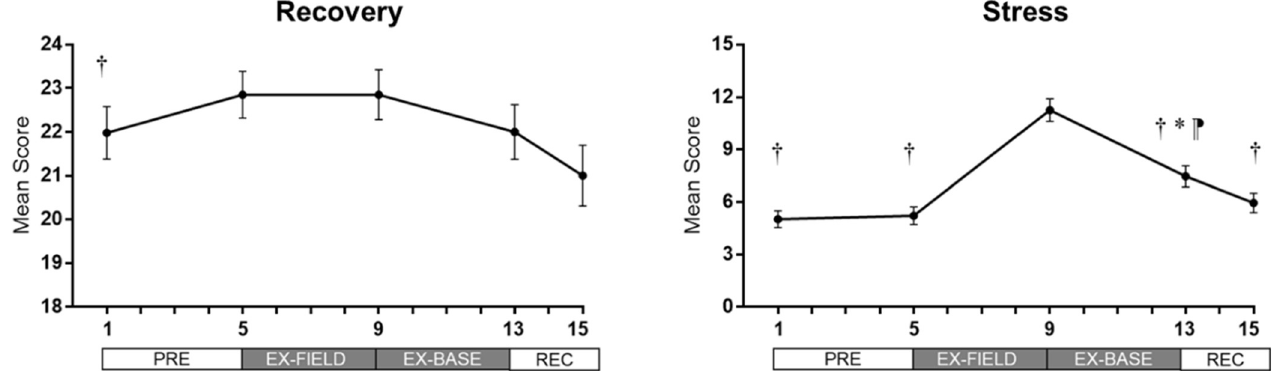
Fig 3. Mean ( ± SEM) changes in self-reported stress and recovery during 16-day study period. � p < 0.05 vs day 1; ⁋ p < 0.05 vs day 5; † p < 0.05 vs day 9.